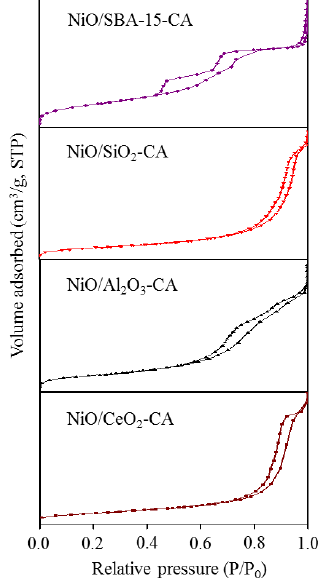
Figure 2. Nitrogen adsorption desorption isotherms of different catalysts.